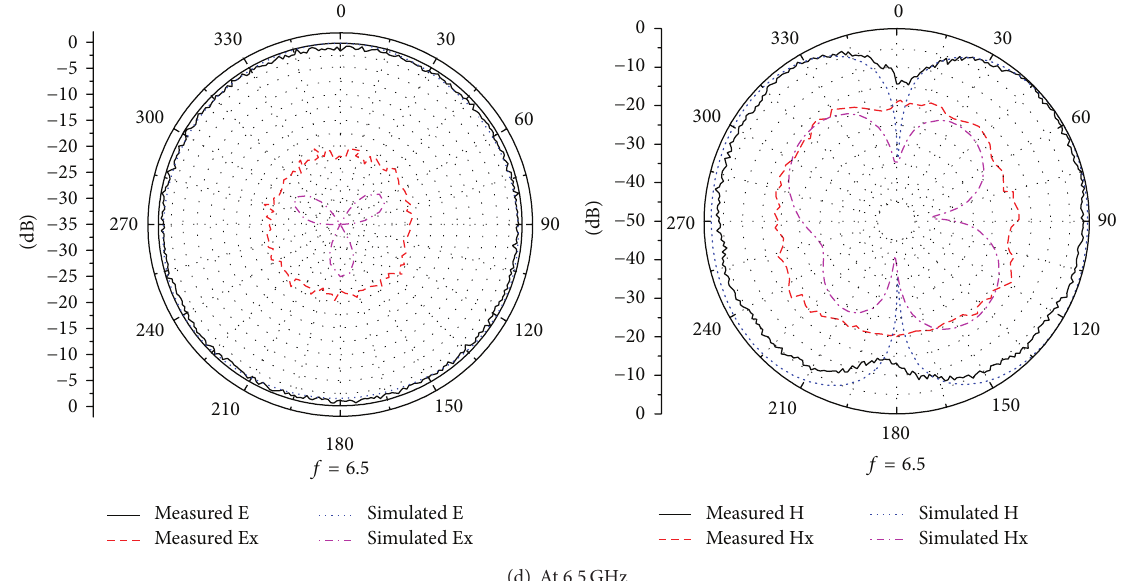
Figure 5: Simulated and measured microwave radiation patterns at (a) 4.8 GHz, (b) 5.2 GHz, (c) 5.8 GHz, and (d) 6.5